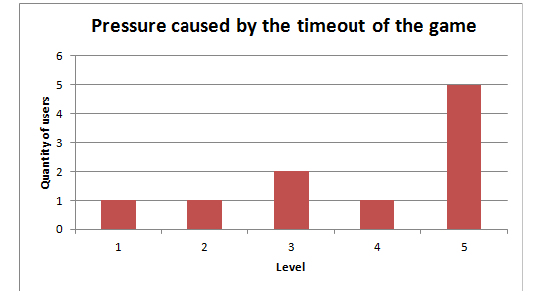
Figure 22. ViMeTGame evaluation question about the mouse usage. Scale: 1 to “Disagree”and 5 to “Fully agree”.